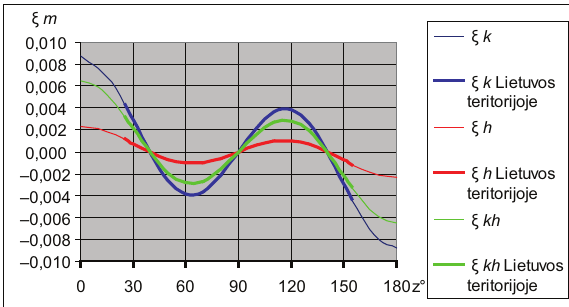
Fig. 3. Deformations of surfaces due to the Moon effect ( n =